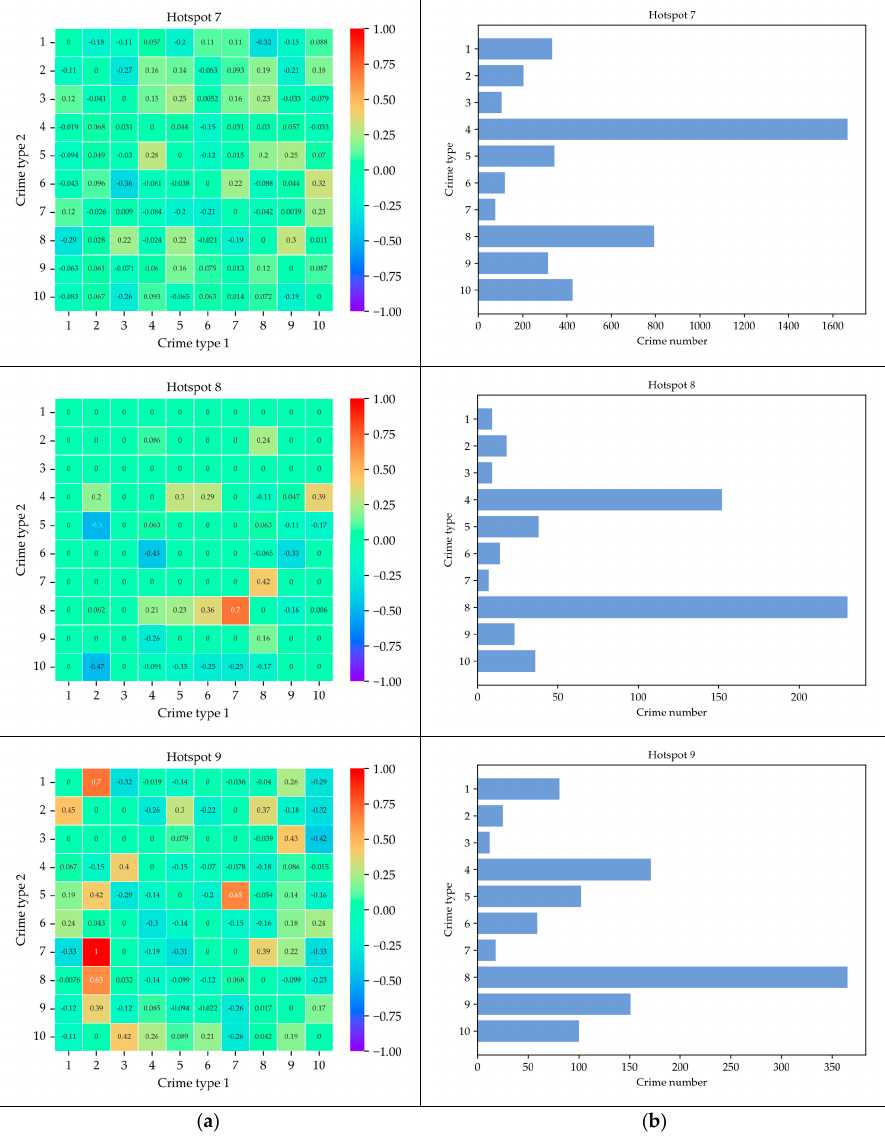
Figure 3. ( a ) Correlation coe ffi cients of crime types in hotspot areas. ( b ) Number of cases of a given crime type in each hotspot area. (Note: di ff erent digital identi fi ers on the axes represent di ff erent crime types, as follows: (1) pickpocketing, (2) vehicle property theft, (3) o ffi ce creeper activity, (4) vehicle theft, (5) shoplifting, (6) telecom fraud, (7) robbery, (8) home burglary, (9) internet fraud, and (10) delict.)